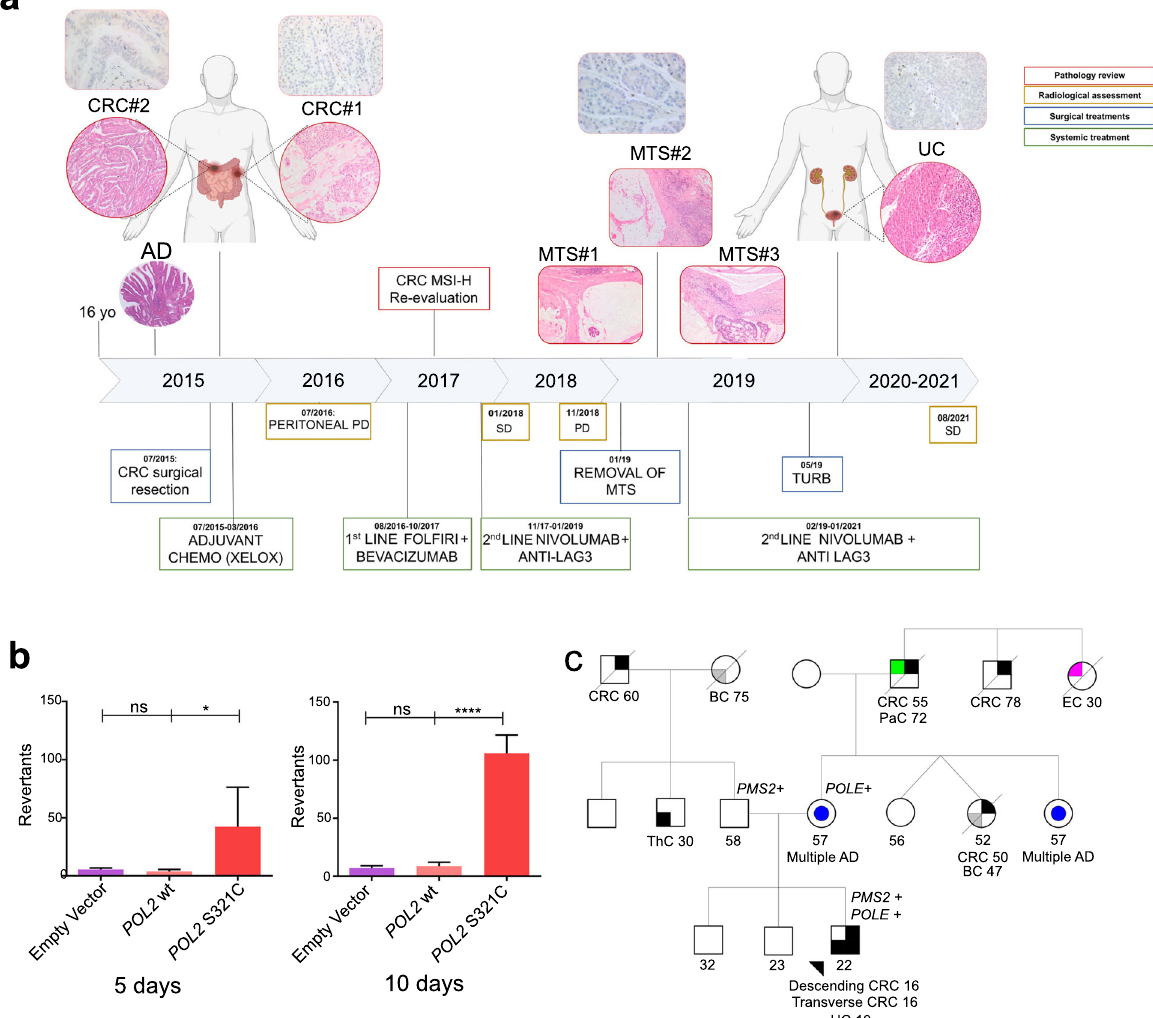
Fig. 1 Patient clinical history and validation of the POLE variant. a Below the time bar surgical events (blue) and treatment regimens (green) are reported. Above the bar, Hematoxylin and Eosin (H&E) and PMS2 IHC images of the histological samples and diagnostic molecular status (red). Circular images: primary carcinomas; rectangular images: metastases. Yellow boxes include RECIST criteria details. b Saccharomyces cerevisiae pol2 Δ haploids auxotrophic for tryptophan (trp1-1) and carrying an empty vector, a centromeric plasmid with the wild-type or pol2- S312C allelic variant were plated on media lacking tryptophan to probe for their ability to revert the amber trp1-1 mutation, thus permitting the growth of revertants in tryptophan-de fi cient media. Two independent clones per 2 × 10 7 cell divisions were tested in triplicate for each strain. Errors bars show the mean standard deviation of two biological replicates (3x technical replicates of each genotype). P value was calculated with one-way ANOVA and Tukey ’ s multiple comparisons test (signi fi cant * P < 0.05; **** P < 0.0001). c Family Pedigree, with the PMS2 and the POLE variants reported. AD adenoma, BC breast cancer, CRC colorectal cancer, EC endometrial cancer, PaC pancreatic carcinoma, MTS metastasis, PD progression disease, SD stable disease, ThC thyroid cancer, TURB trans-urethral resection of the bladder, UC urothelial